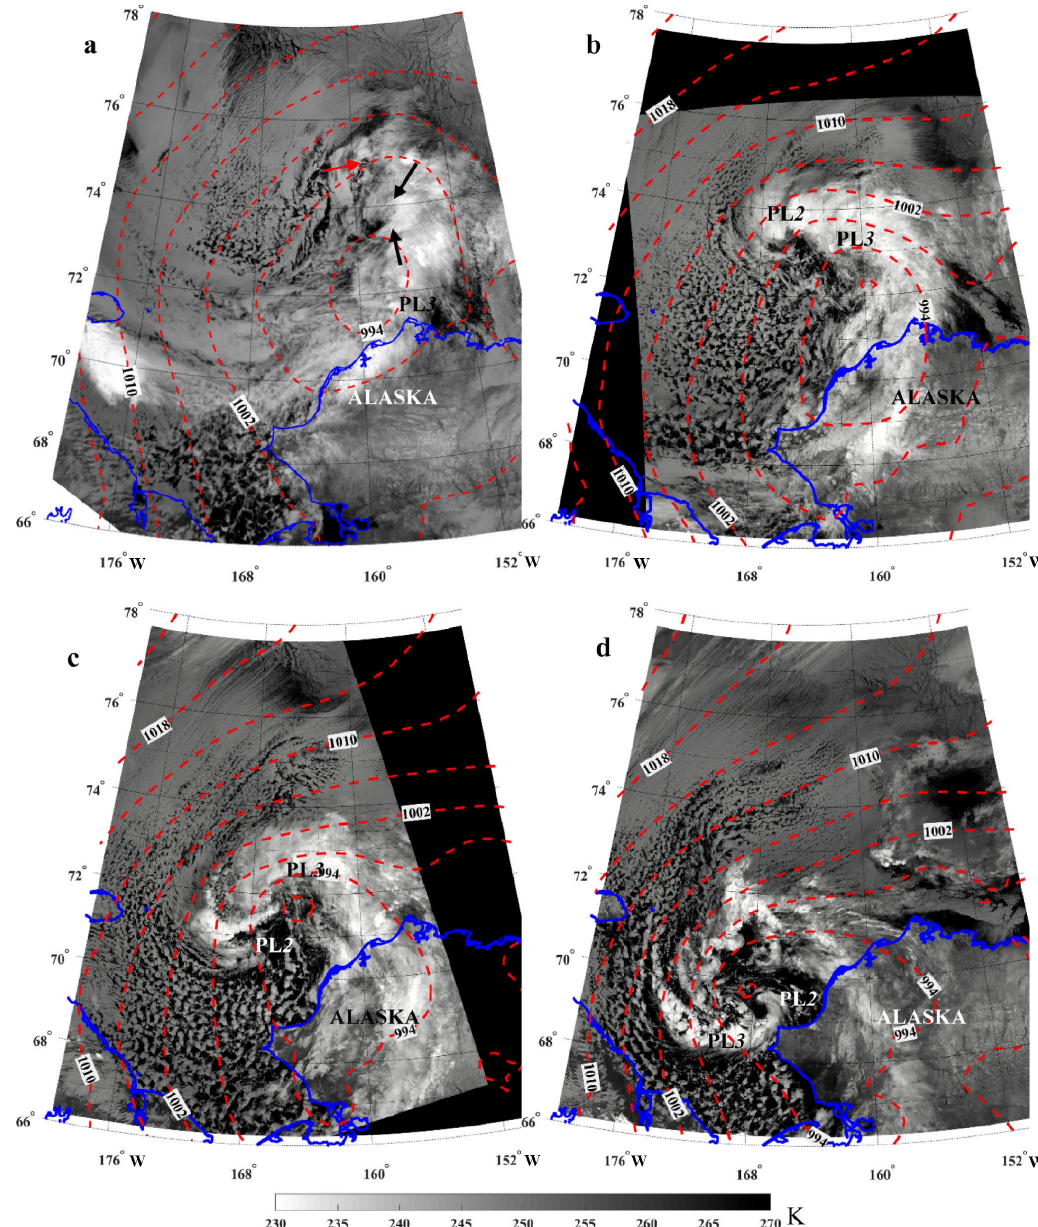
Figure 4. PLs evolution on IR images obtained from: the AVHRR at 04:45 UTC ( a ) and VIIRS at 12:05 UTC ( b ), 17:05 UTC ( c ) and 22:05 UTC ( d ) on 19 October 2017. The red dotted lines are the SLP fields by ERA5. The red and black arrows indicate the genesis areas of PL 2 and PL 3 ,